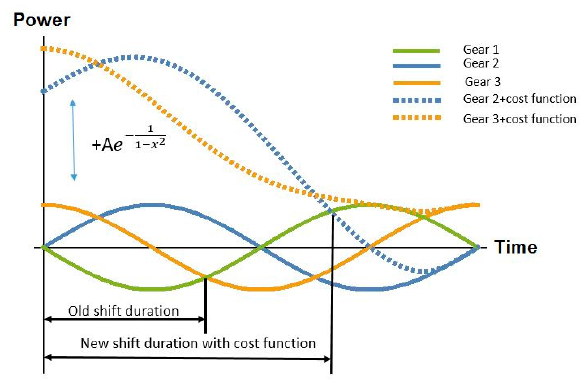
Figure 5. The schematic diagram of the designed cost function.